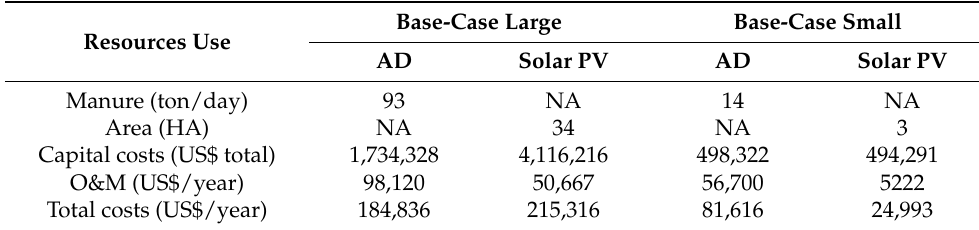
Table 3. Manure, land, and costs required to install an AD system and a solar PV system to produce electricity at both base-case farms.